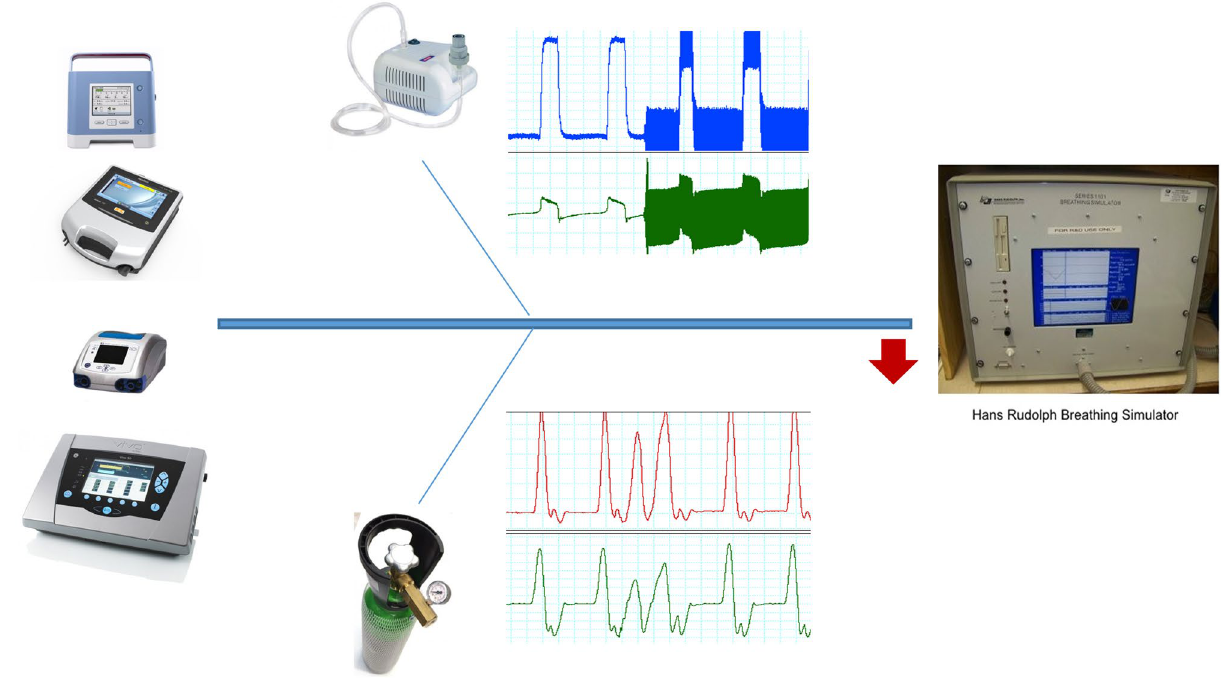
Figure 1. Bench study